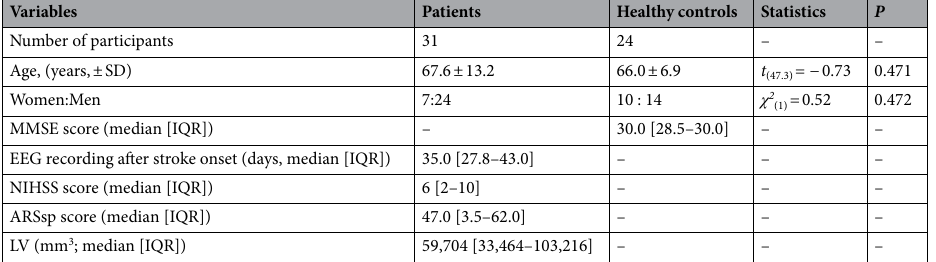
(Fig. 3a ‒ c) revealed a positive correlation of the F7F8-PSI (β1) with the ARSsp score and negative correlations